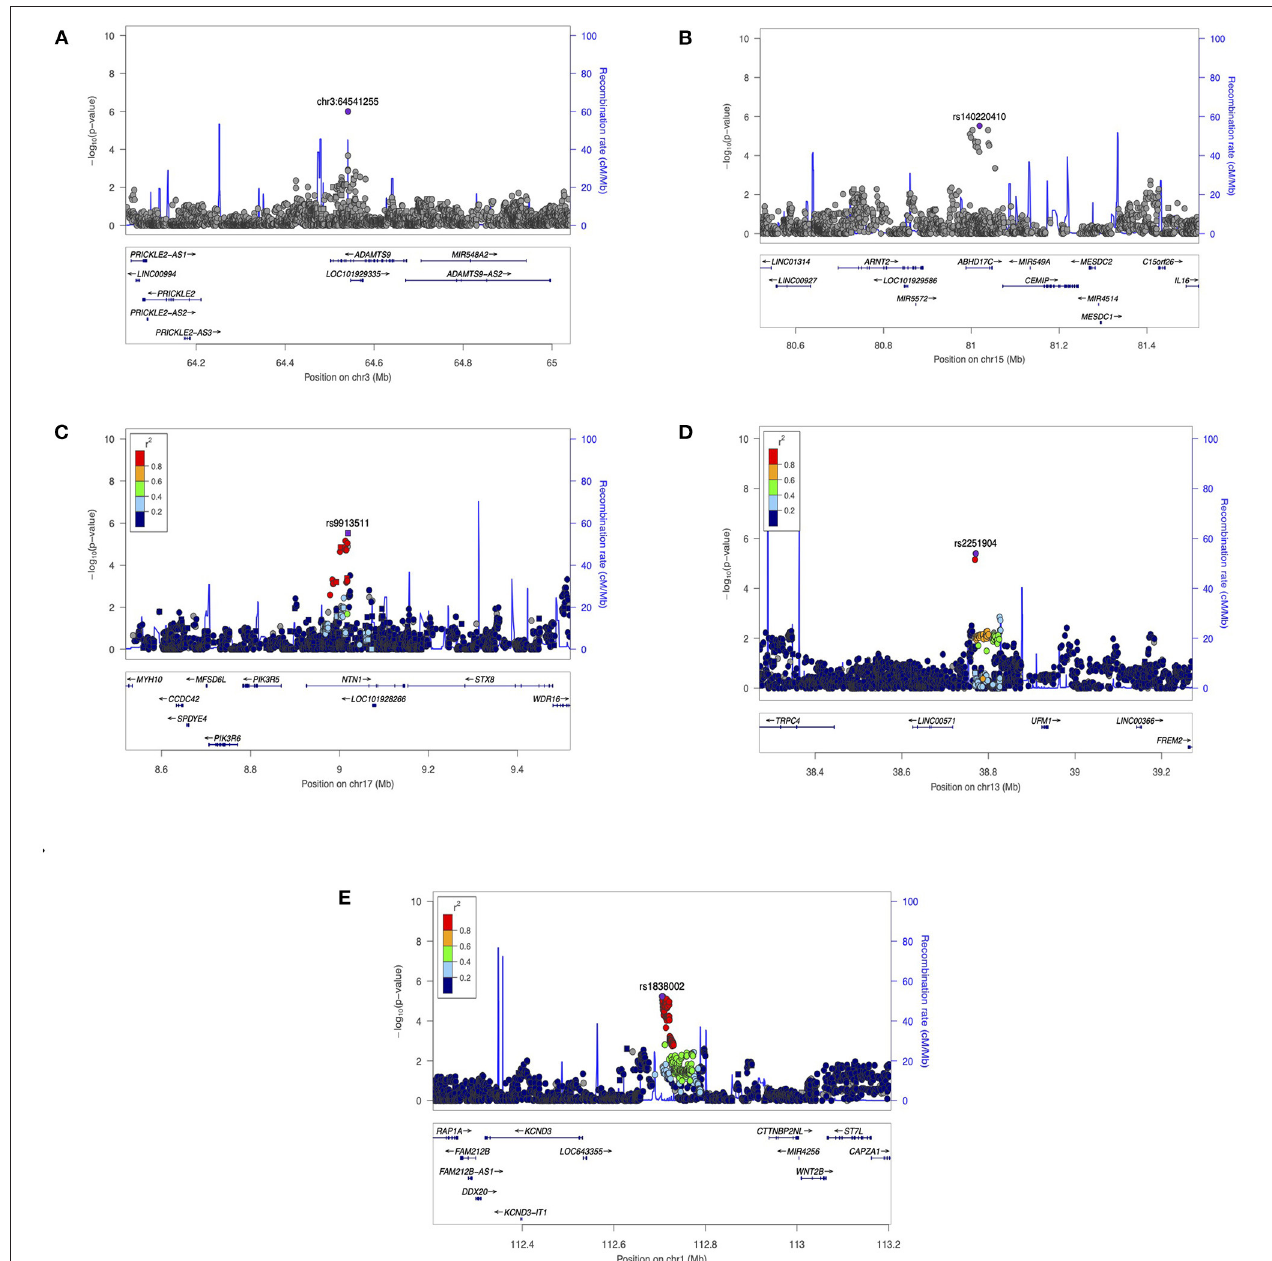
FIGURE 2 | Regional Association Plots from (AIR) results. LocusZoom were used to generate plots for regions of Interest. (A) Suggestive locus near ADAMTS9 and PRICKLE2 on chromosome 3. (B) suggestive locus near ARNT2 gene on chromosome 15. (C) Suggestive locus near NTN1 gene on chromosome 17. (D) Suggestive locus near TRPC4 on chromosome 13. (E) Suggestive locus near WNT2B gene on chromosome 1. The genome build used for the recombination rate was based on 1,000 Genomes November 2014 EUR data. All of the gene positions and directions of transcription are annotated on the plots.